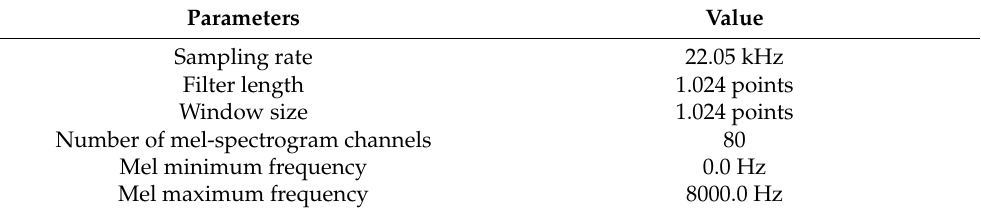
Table 4. Audio data parameters.